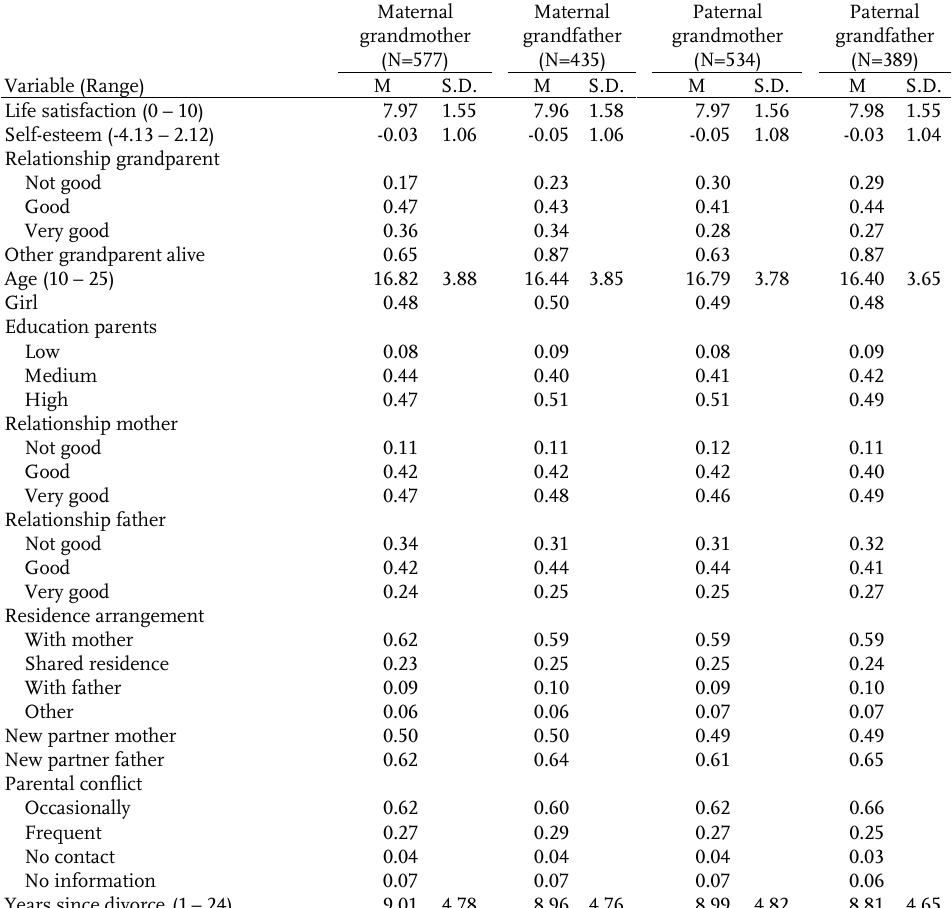
Table 1 : Descriptive statistics of variables used in the analysis of each grandparent-sample: Means (M) and Standard Deviations